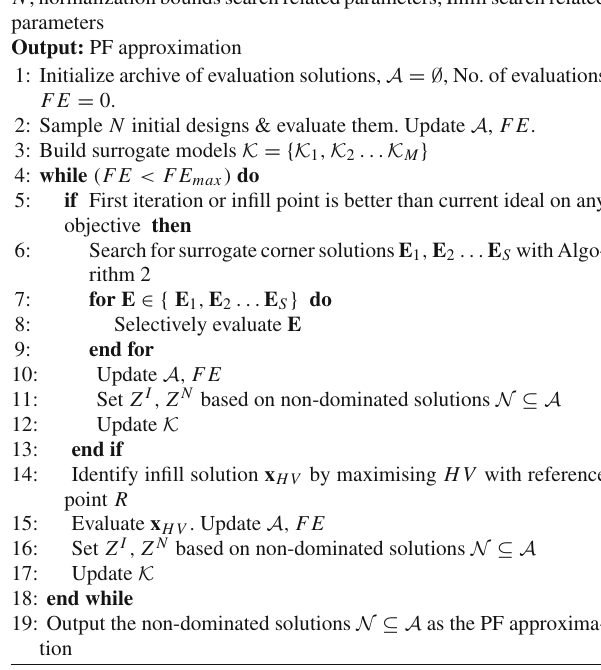
Algorithm 1 Proposed HV infill-based algorithm